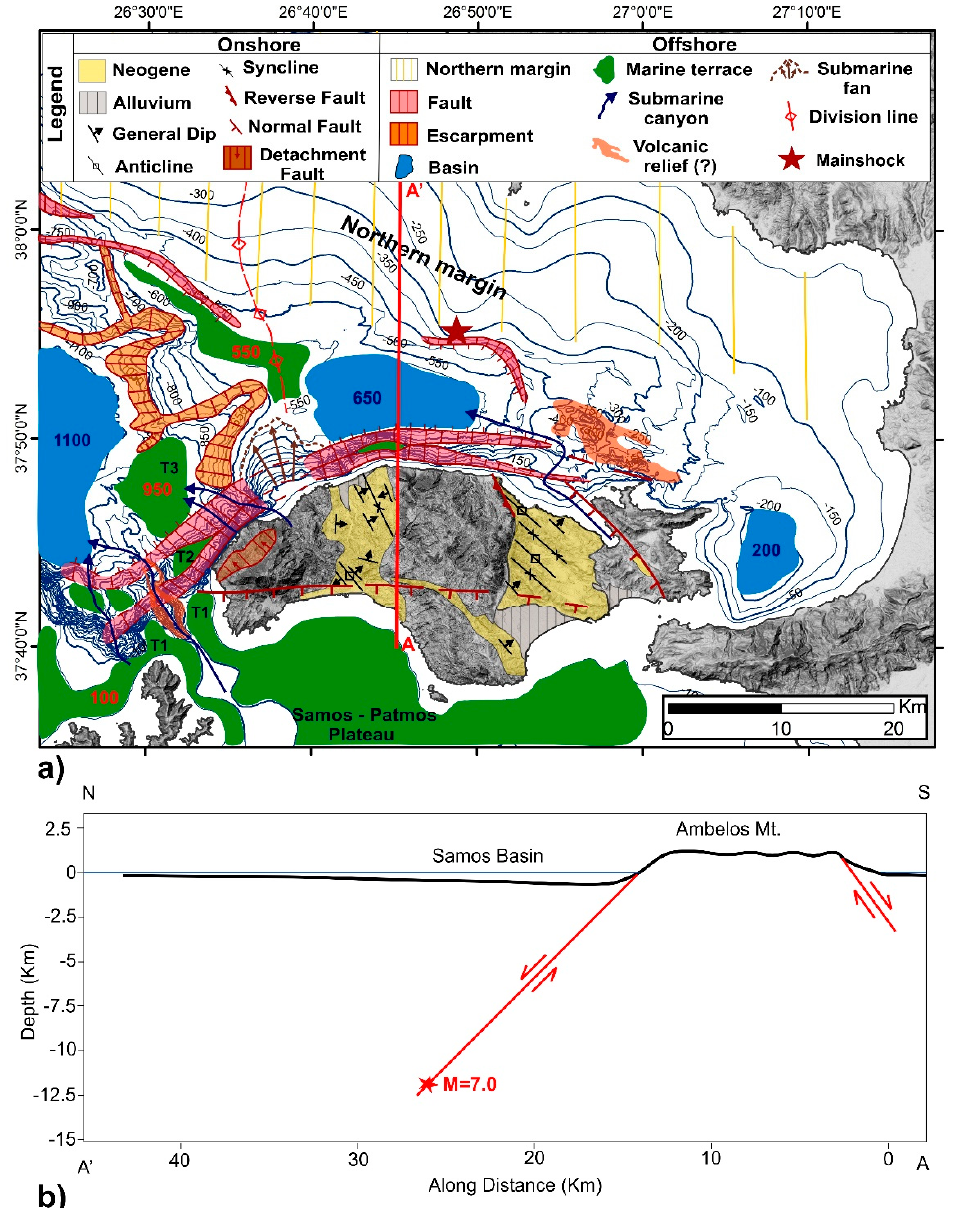
Figure 8. ( a ) Morphotectonic map of Samos Island and Samos Basin. ( b ) N-S cross section through the Samos Basin and Samos island. The E–W marginal fault is dipping to the north with 45 ◦ . The focus of the mainshock of magnitude 7.0 is shown at 12 km depth. The fault plane solutions of the October 30th seismic sequence [10] generally show E–W normal faulting (Figure 6a). The main shock (Magnitude 7.0) and most of the aftershocks (Magnitudes 5.2–3.9) occur in the central and eastern part of Samos Basin, forming a 20 km long seismic belt, which is smaller than expected for this magnitude (following the empirical relationships [45]). However, it is remarkable that: (i) there are no (large) aftershocks in the western part of Samos Basin, (ii) there are some aftershocks with similar plane solutions onshore in the eastern part of Samos Island, south of the major fault zone and (iii) there are some aftershocks at the eastern part of Ikaria Basin with the indication of strike-slip components besides E–W normal faulting. Thus, the aftershocks (of magnitude >3.9) indicate a “seismic gap zone” of about 20 km length extending from the Eastern Ikaria Basin up to the central Samos Basin. The focal depths indicate a seismic layer at a uniform level at 12–13 km in the activated area. Thus, the activated fault should have an average dip of 45 ◦ to the north, as shown in the N–S tectonic profile through Samos Island and Samos Basin (Figure 8b). This tectonic structure is compatible with the morphotectonic analysis and the very steep slopes of the Samos